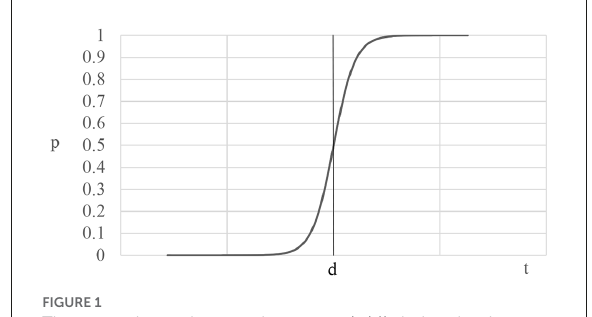
FIGURE1 The curve shows the neural response ( n ( t )) during the time one views a video ( t ). When the Acceleration threshold ( d ) is passed, the probability of a post-video action rises